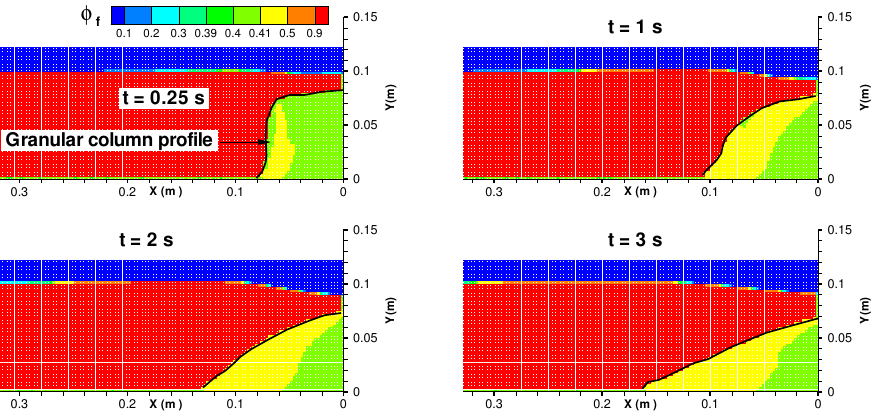
Figure 9. Numerical results show the evolution of water free surface and granular profile indicated by the water volume fraction φ f at some representative times for the initially dense packing